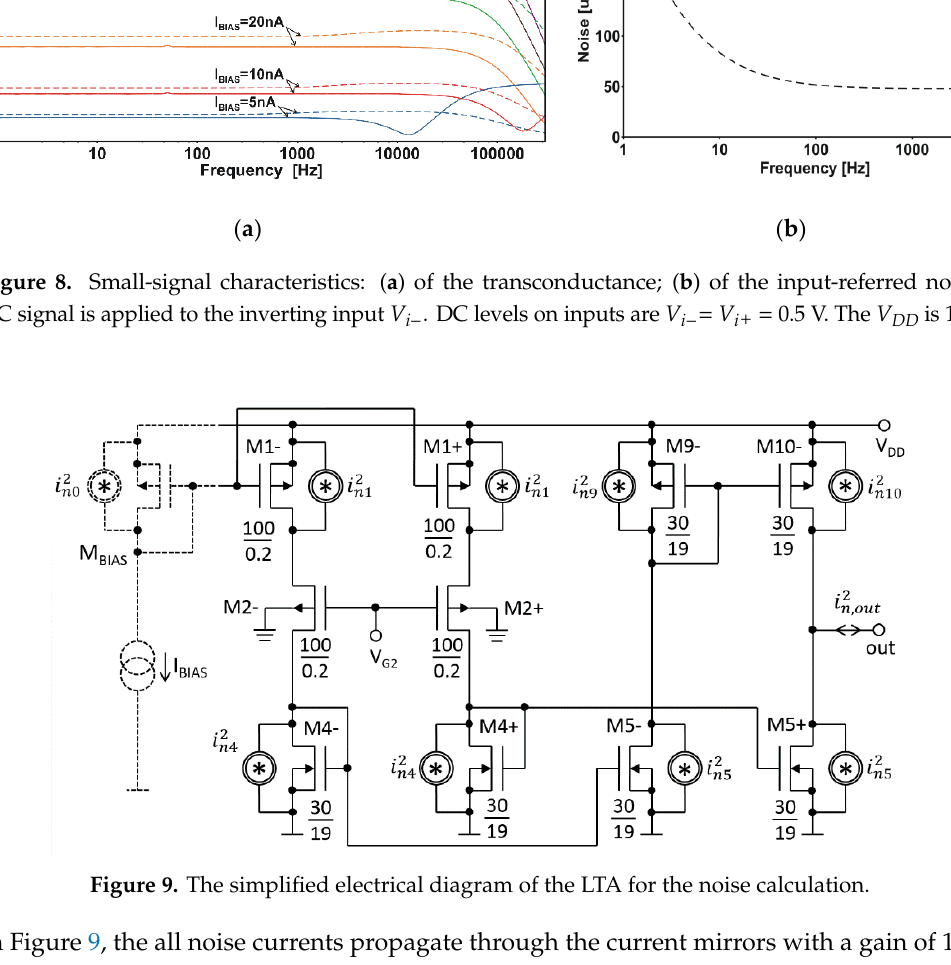
Figure 8. Small-signal characteristics: ( a ) of the transconductance; ( b ) of the input-referred noise. AC